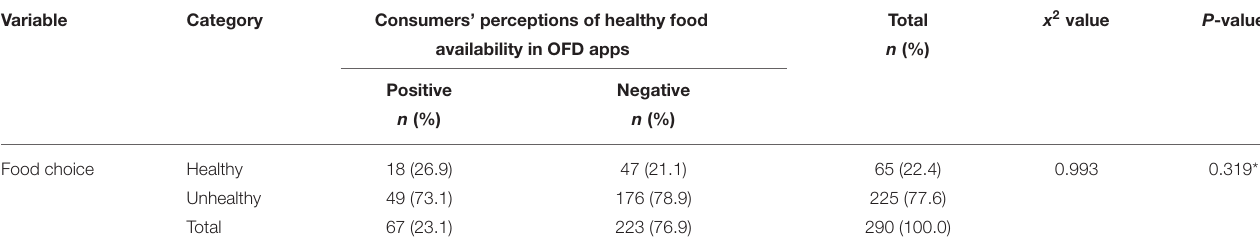
TABLE 7 | Association between consumers’ perceptions of healthy food availability in OFD apps and their food choices.